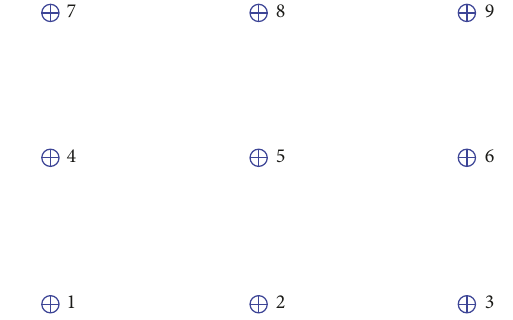
Figure 4: Configuration of GHEs with 3 × 3 square borehole array.